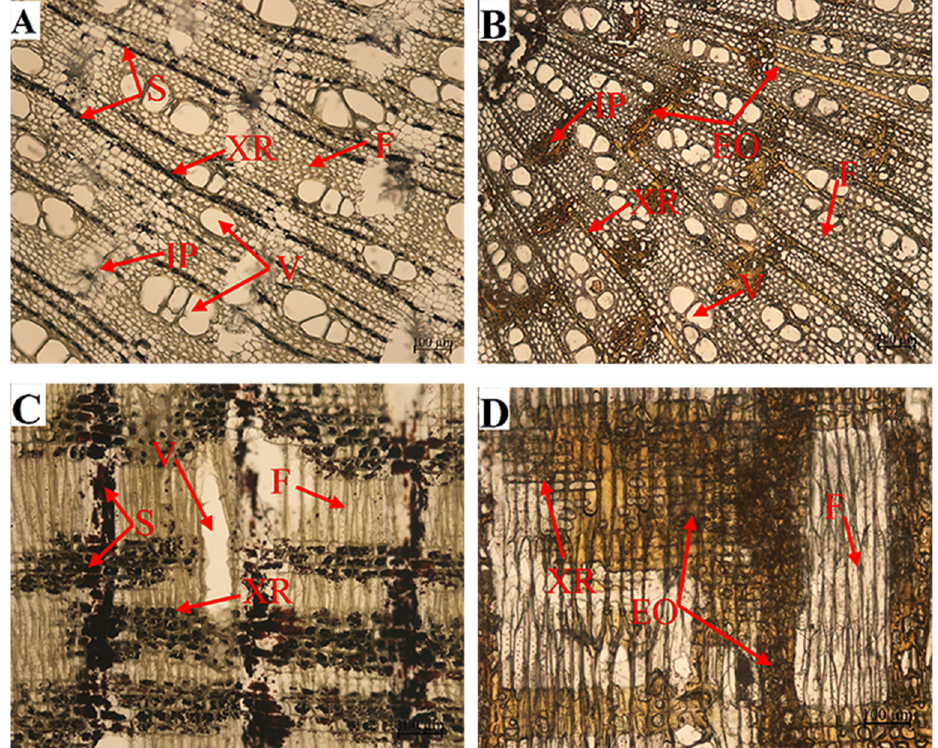
Figure 6. Starch grains in wood ray cells before ( A , C ) and after treatment ( B , D ). Cross-section of the stem ( A , B ), radial-section of the stem ( C , D ). “XR” xylem rays; “S” starch; “F” fiber; “V” vessel; “IP” interxylary phloem; “EO” essential oil.